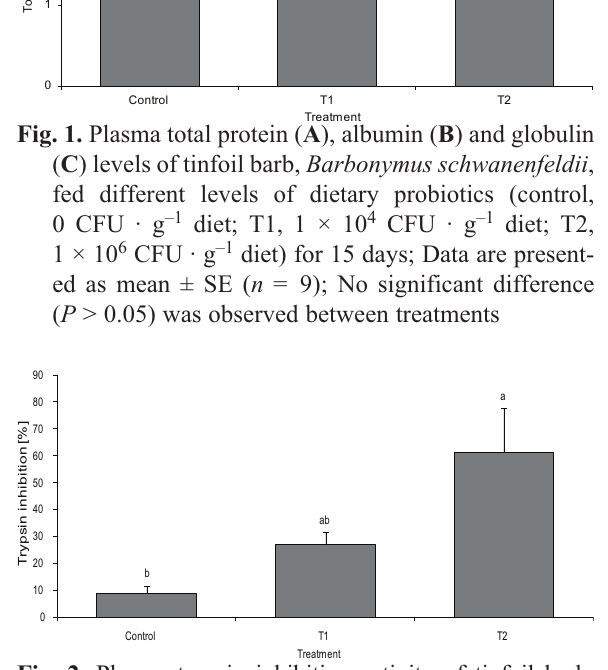
Fig. 2. Plasma trypsin inhibition activity of tinfoil barb, Barbonymus schwanenfeldii , fed different levels of dietary probiotics (control, 0 CFU · g –1 diet; T1, 1 × 10 4 CFU · g –1 diet; T2, 1 × 10 6 CFU · g –1 diet) for 15 days; Data are presented as mean ± SE ( n = 9); Bars with dif- ferent letters were significantly different ( P < 0.05)